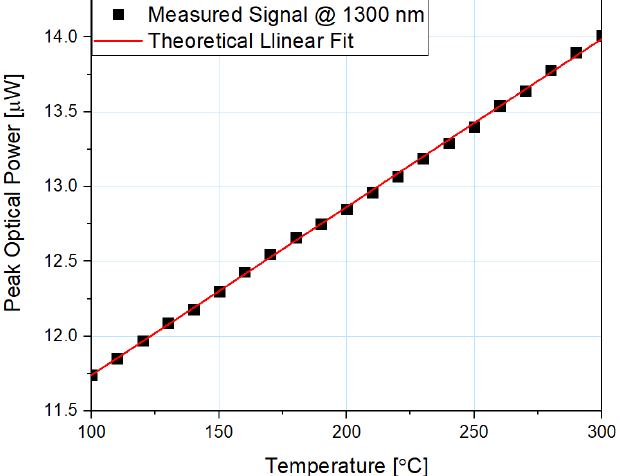
Figure 7. Reflected signal peak optical power dependence on the changing temperature and its theoretical linear fit, measured at a wavelength of 1300 nm, using the microsphere-based sensor with 100 nm ZnO ALD coating.